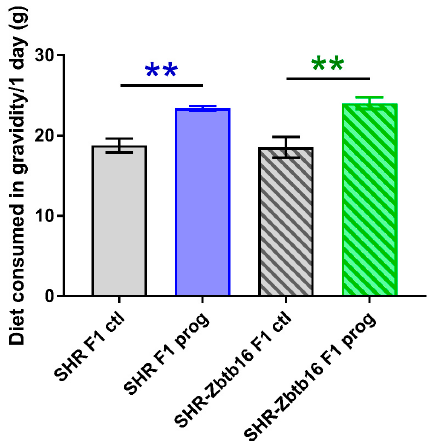
Figure 5. Diet consumption of F1 SHR and SHR-Zbtb16 adult female rats in gravidity. SHR F1 control females (grey bars), SHR-Zbtb16 F1 control females (grey patterned bars), F1-programmed SHR females (blue bars), F1-programmed SHR-Zbtb16 females (green patterned bars) daily consumption throughout 3 weeks of gravidity. Data are expressed as mean ± SEM. The strain comparison using the post-hoc